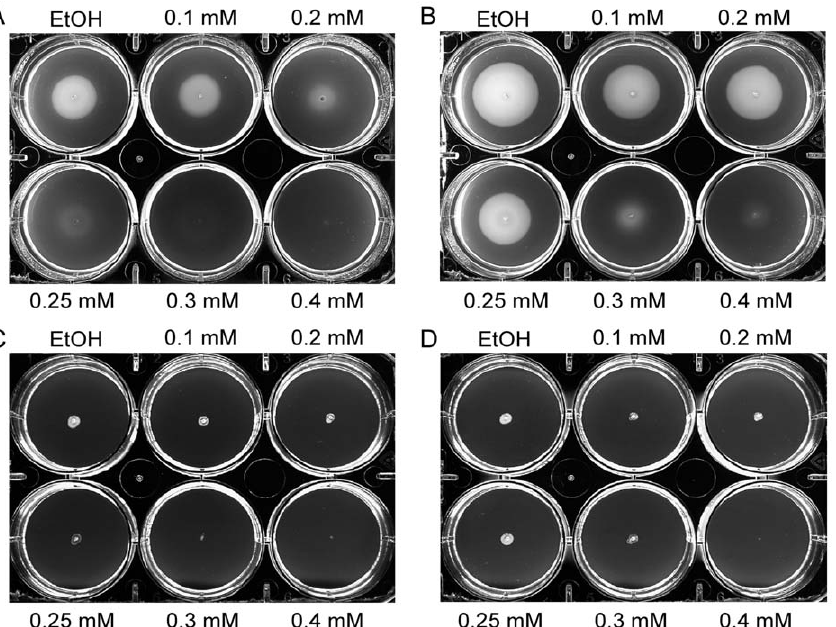
Figure 2. Inhibition of C.jejuni motility by carvacrol. Swarming of C. jejuni strain 108 (A) and 81116 (B) and the non-motile mutants 108 D motAB (C) and in 81116 D motAB (D) in thioglycollate agar in the absence and presence of the indicated concentrations of carvacrol after 24 h of growth. The carvacrol solvent ethanol (EtOH) served as negative control.